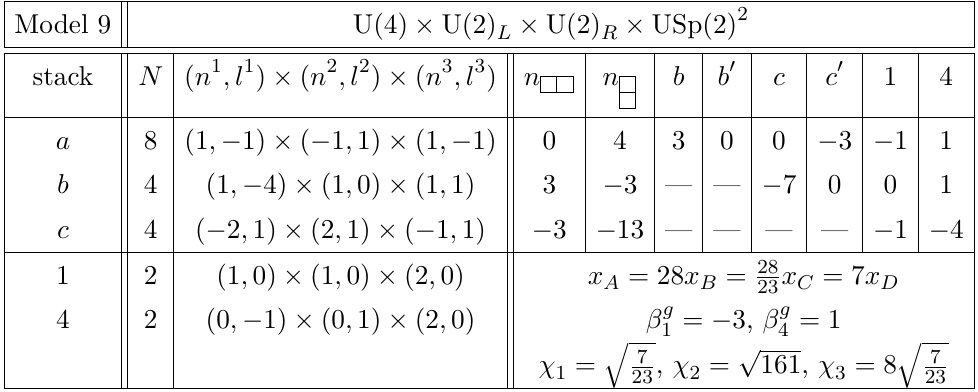
Table 16 . D6-brane configurations and intersection numbers of Model 9, and its MSSM gauge